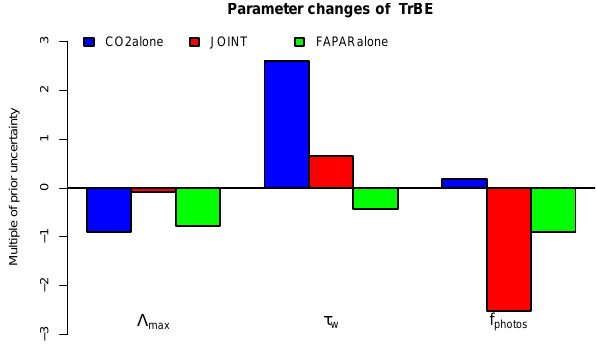
Figure 8. Parameter changes of tropical evergreen trees in multiples of the prior uncertainty (as